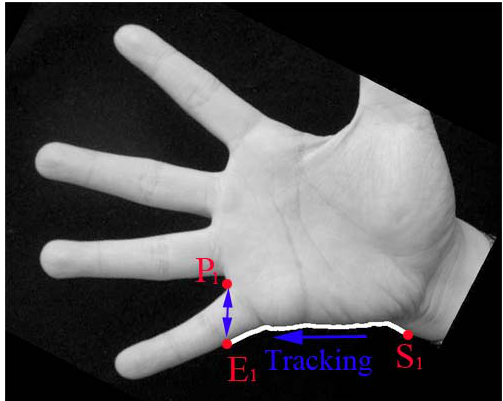
Figure 6. Determine a segment of palm boundary around the start point of heart line by boundary